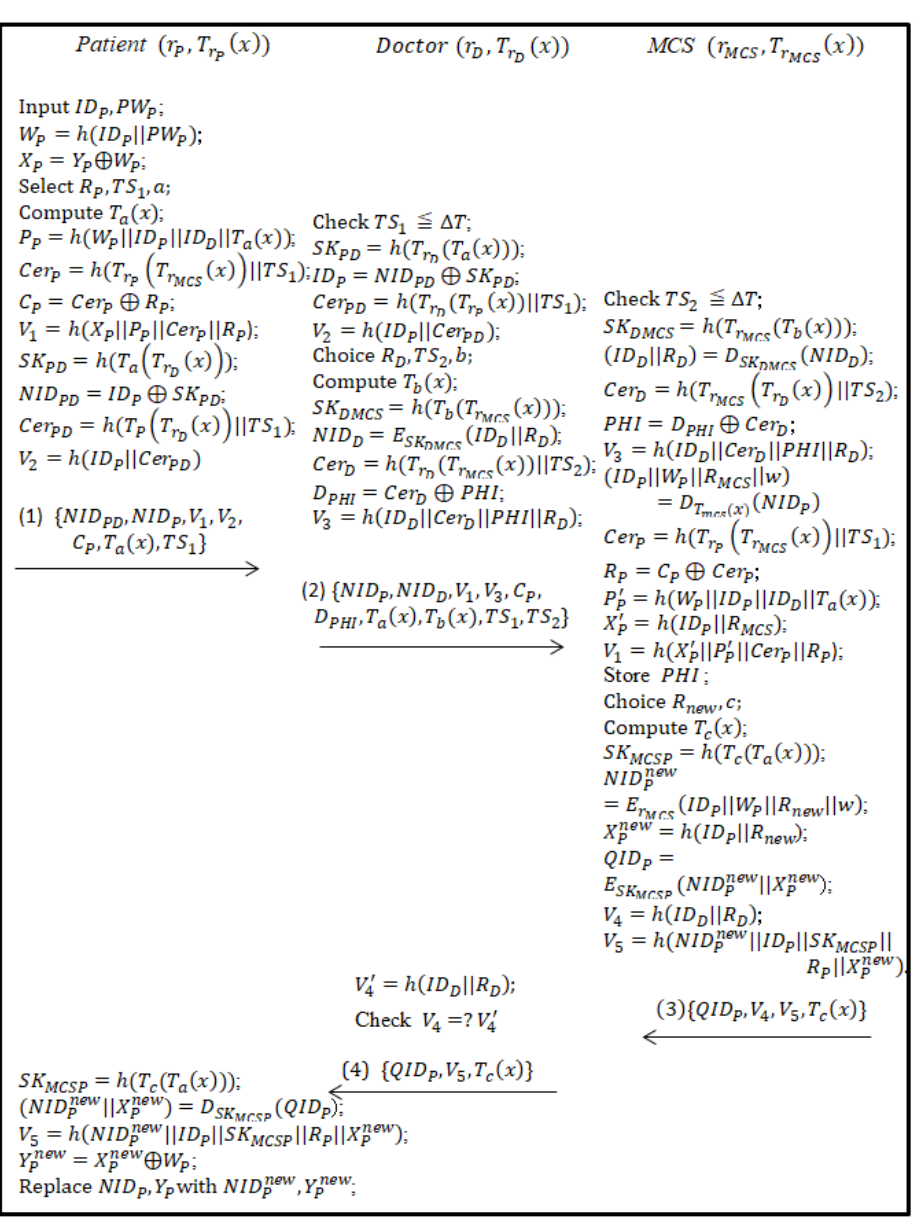
Figure 3. The processes of PHI uploading phase of the proposed scheme.